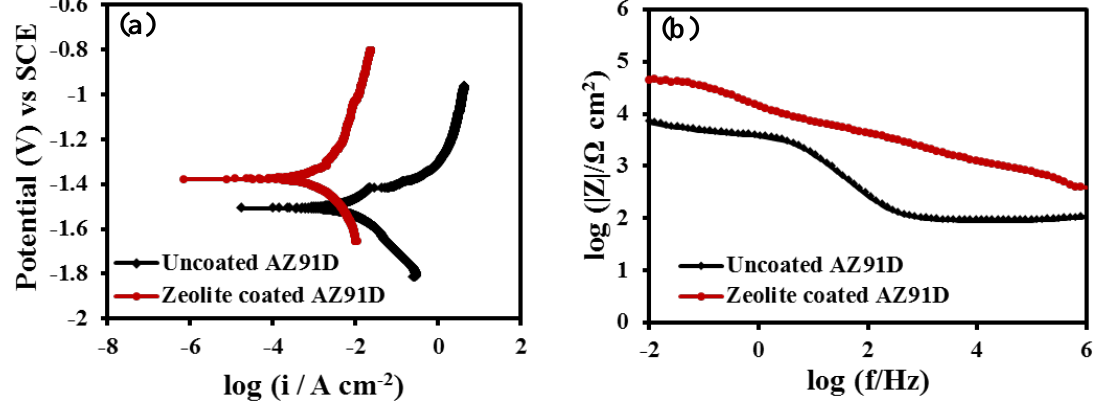
Figure 3. ( a ) Potentiodynamic polarisation and ( b ) Bode (|Z|) plots of the uncoated